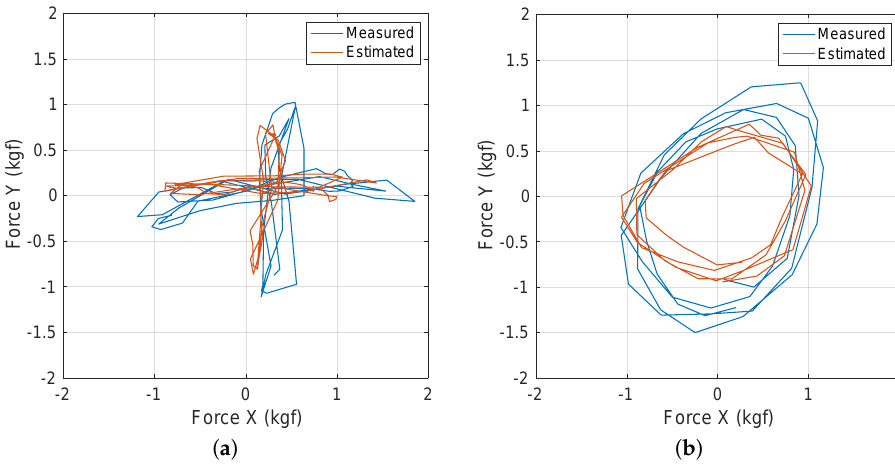
Figure 7. Estimated vs. measured forces for two types of interaction experiments: ( a ) vertical and horizontal forces during 4 s, and ( b ) circular forces trying to describe a circle for 2.8